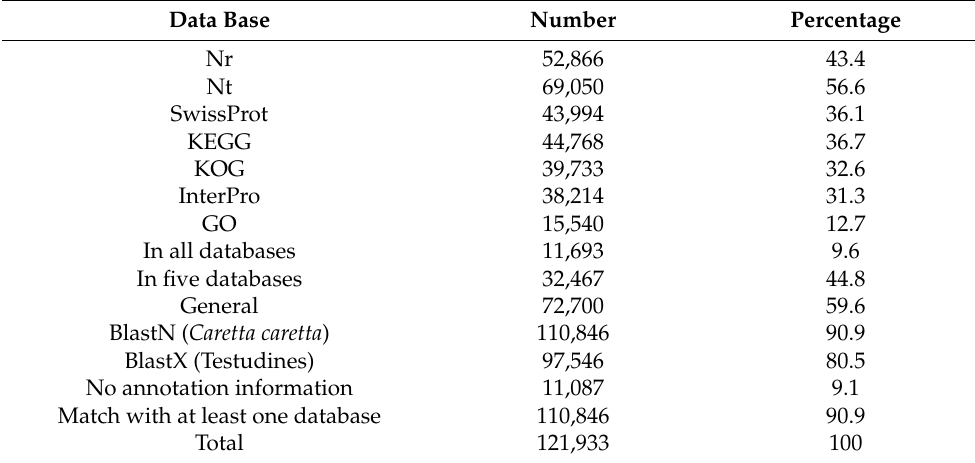
Table 2. Statistics of the annotation of the composite transcriptome of the loggerhead turtle, Caretta caretta , with the number of transcripts that have at least one match with one of the evaluated databases. Some transcripts had multiple annotation